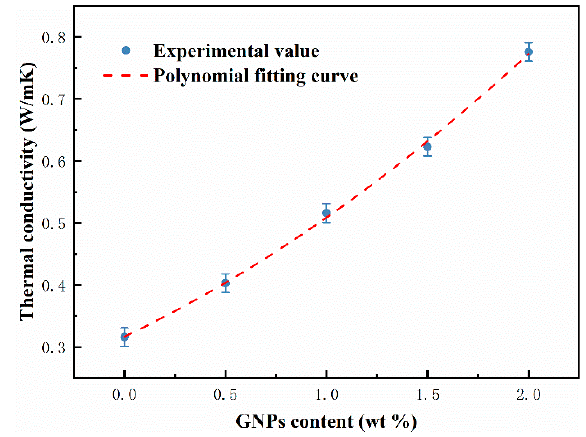
Figure 7. Thermal conductivity of the composites with different contents of GNPs.